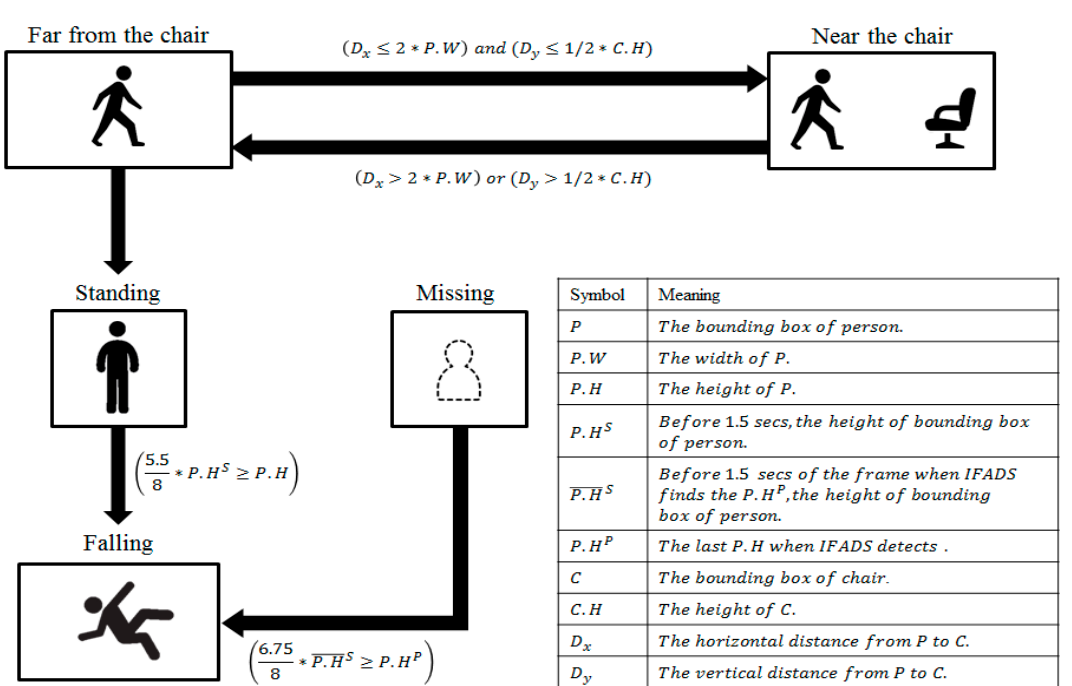
Figure 2. The flow of the state when the person is far from the chair.